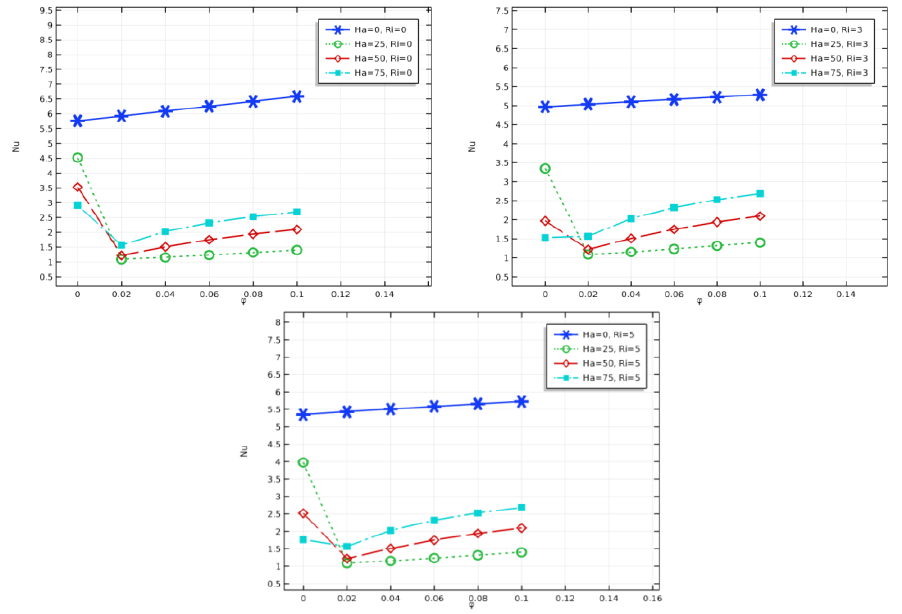
Fig. 12. Effect of φ on average Nusselt Number for different Ha and Ri.